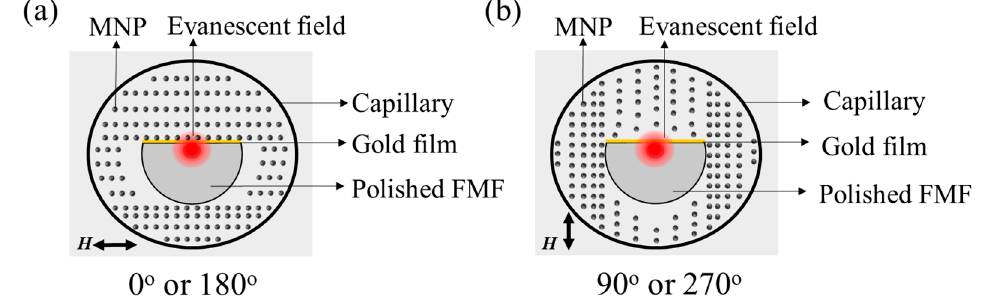
Figure 3. Schematic diagrams of the magnetic nanoparticles (MNPs) distribution around the side-polished fiber, when the external magnetic field is ( a ) parallel and ( b ) perpendicular to the flat surface of the side-polished fiber.